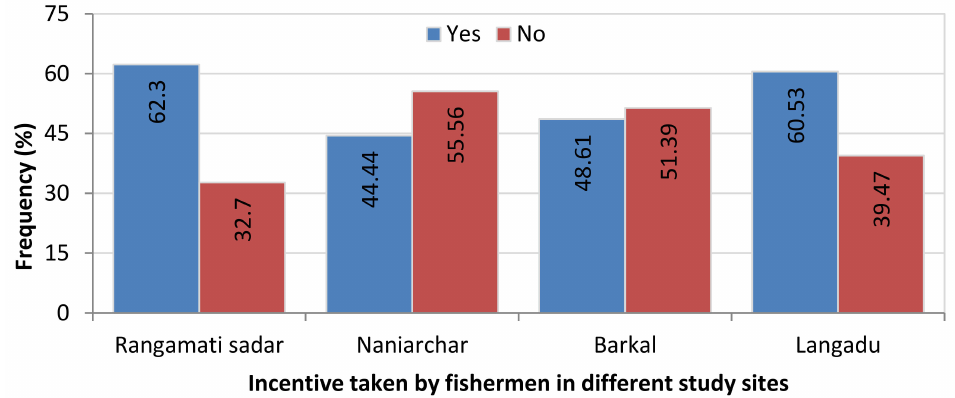
Figure 5. Incentives taken by fishers in different study sites of Kaptai